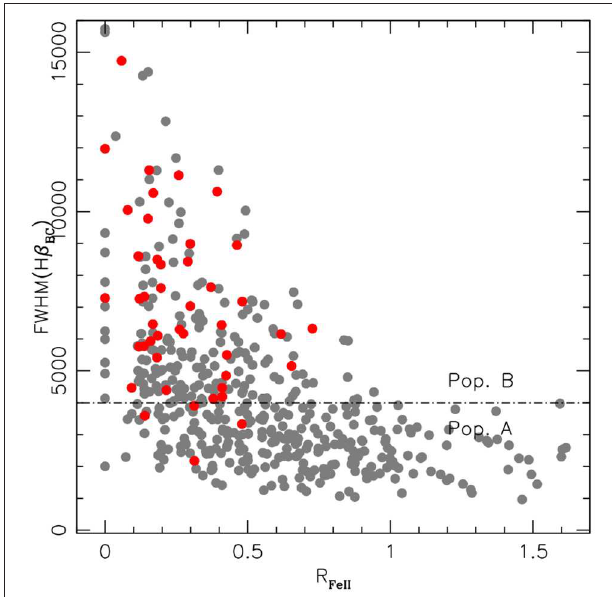
FIGURE 6 | The 4DE1 optical plane involving the width of H β and the strength of optical FeII. The horizontal line marks the boundary between population A (lower half of the diagram) and B (upper half) sources. Source occupation is shown for the 470 brightest SDSS-DR5 quasars ( z < 0.75) with highest S/N SDSS spectra (Zamfir et al., 2008). Gray and red dots represent RQ and lobe dominated LD RL quasars. The latter class shows a strong preference for the Population B